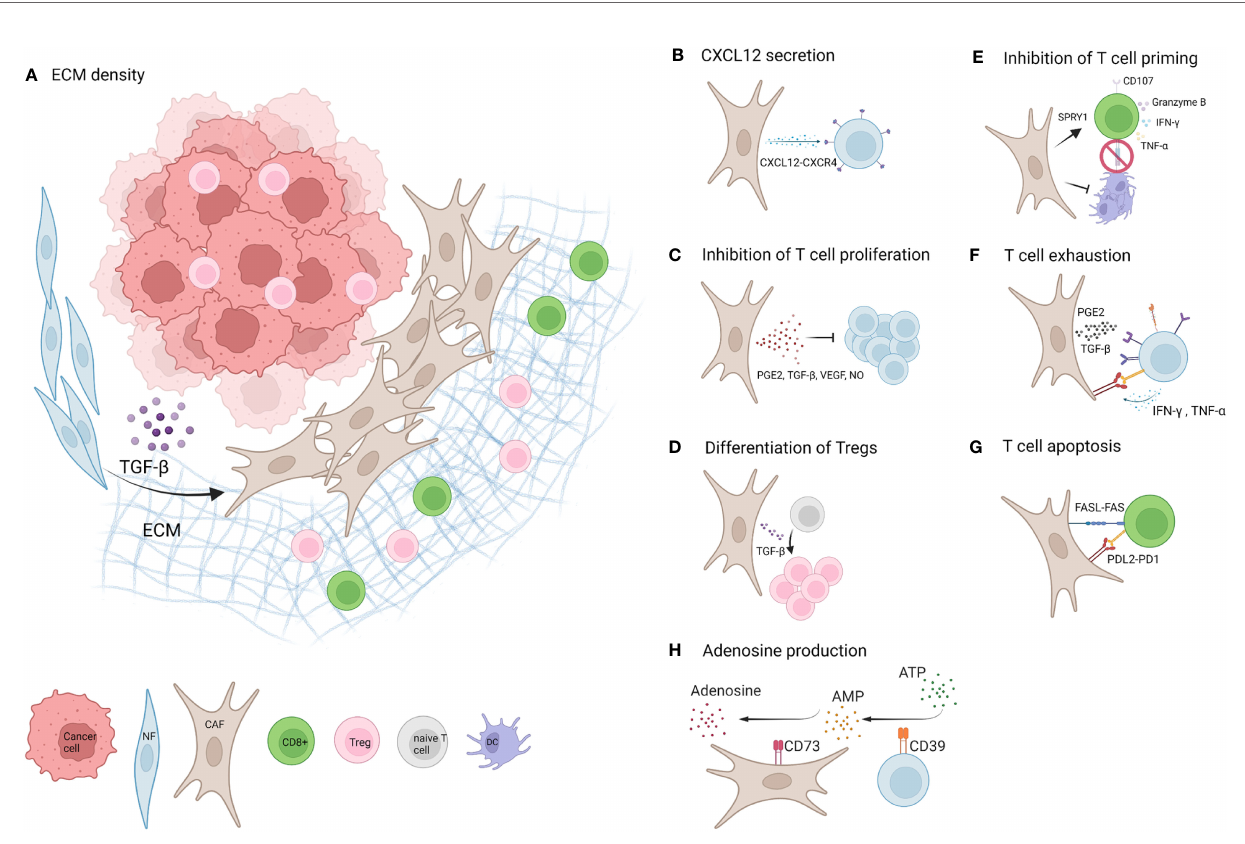
FIGURE 1 | Mechanisms of CAF mediated T cell inhibition. (A) Factors including TGF- b and ECM promote the development of CAFs in the TME of solid tumours. A dense network of CAF secreted ECM restricts T cell mobility and entry of CD8 + T cells to the tumour nest (1). (B) CXCL12 secreted by CAFs binds to CXCR4 on T cells and likely contributes to T cell restriction to the tumour stroma (20 – 22). (C) CAFs limit T cell proliferation by factors including PGE2, TGF- b , VEGF and NO (23 – 27). (D) One study suggests CAF secreted TGF- b promotes differentiation of naive CD4 + T cells into FOXP3 + Tregs (28). (E) CAFs inhibit dendritic cell (DC) differentiation and maturation and thereby limit T cell priming (7, 29). Additionally CAFs upregulate SPRY1 in T cells associated with reduced activation and downregulate CD107, and cause a reduction in secretion of Granzyme B and TNF- a . Opposing studies report an increase or decrease of IFN- g secretion by T cells (7, 30 – 32). (F) CAFs upregulate exhaustion markers PD1, Lag3, TIGIT, Tim3and CD39 on T cells ( via e.g. PGE2 and TGF- b ) and T cells upregulate PD-L1 and PD-L2 expression on CAFs via IFN- g and TNF- a (15, 22, 23, 33 – 36). (G) CAFs promote apoptosis of T cells via high levels of FASL and PDL2 expression and upregulation of FAS and PD1 on T cells (35). (H) CAFs upregulate CD39 on T cells and T cell secreted IFN- g and TNF- a upregulate CD73 expression on CAFs, which could potentially increase the production of immunosuppressive Adenosine (37). Created with